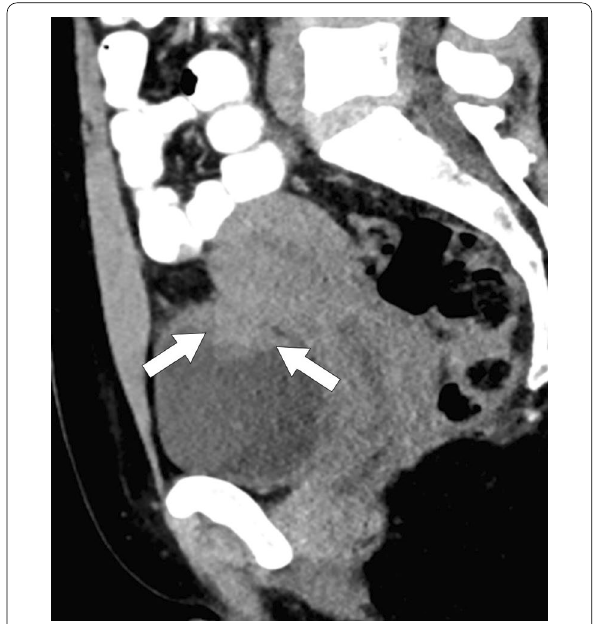
Fig. 29 Deep endometriosis. A 40-year-old woman with no known medical history presenting with pelvic pain and hematuria. Sagittal precontrast CT image shows a nodular soft tissue mass located in the bladder dome inseparable from the anterior uterine wall. A neoplastic uterine mass invading the bladder was suspected. Surgical resection confirmed